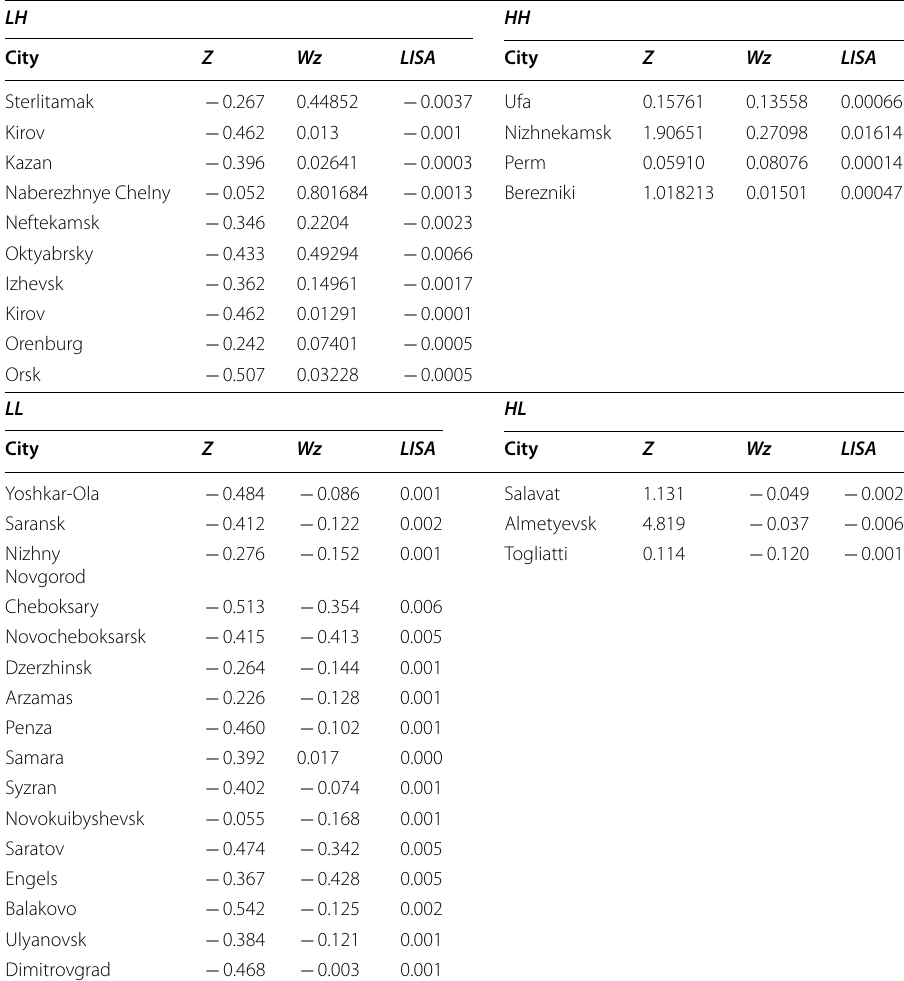
Table 5 Grouping of cities of the Volga Federal District of Russia by the Moran’s index (shipping volume per capita) in 2017 (Russian regions. Main social and economic parameters of cities. 2018 // Federal Service of State Statistics [Electronic resource] URL:http:// www. gks. ru/ free_ doc/ doc_ 2018/ region/ reg- gor18. pdf (date of application